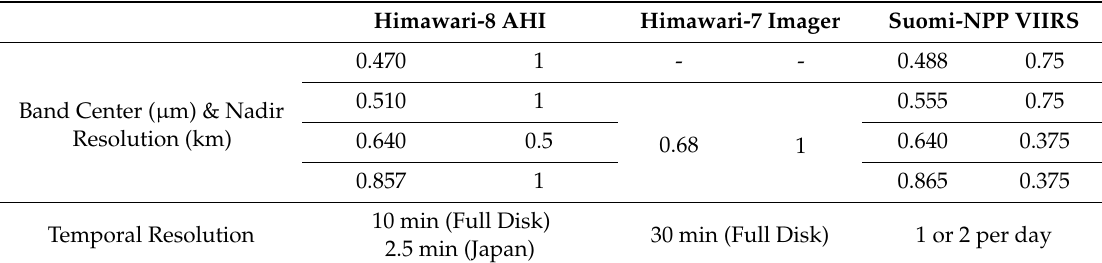
Select Characteristics of Himawari-8 AHI Compared to Himawari-7 Imager and Suomi-NPP